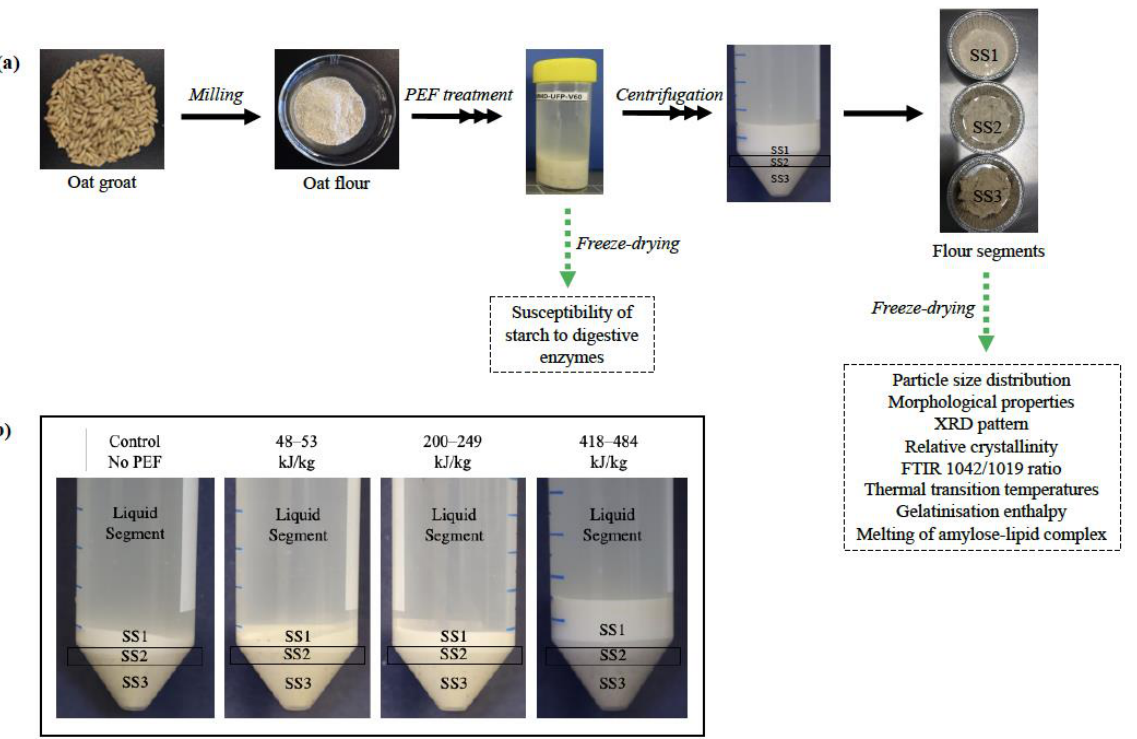
Figure 1. ( a ) Experimental design used in understanding the impact of PEF treatment application on oat flour properties through a systematic evaluation of its flour segments. ( b ) Different flour segments observed after PEF treatment of oat flour. “SS” refers to Solid Segment.